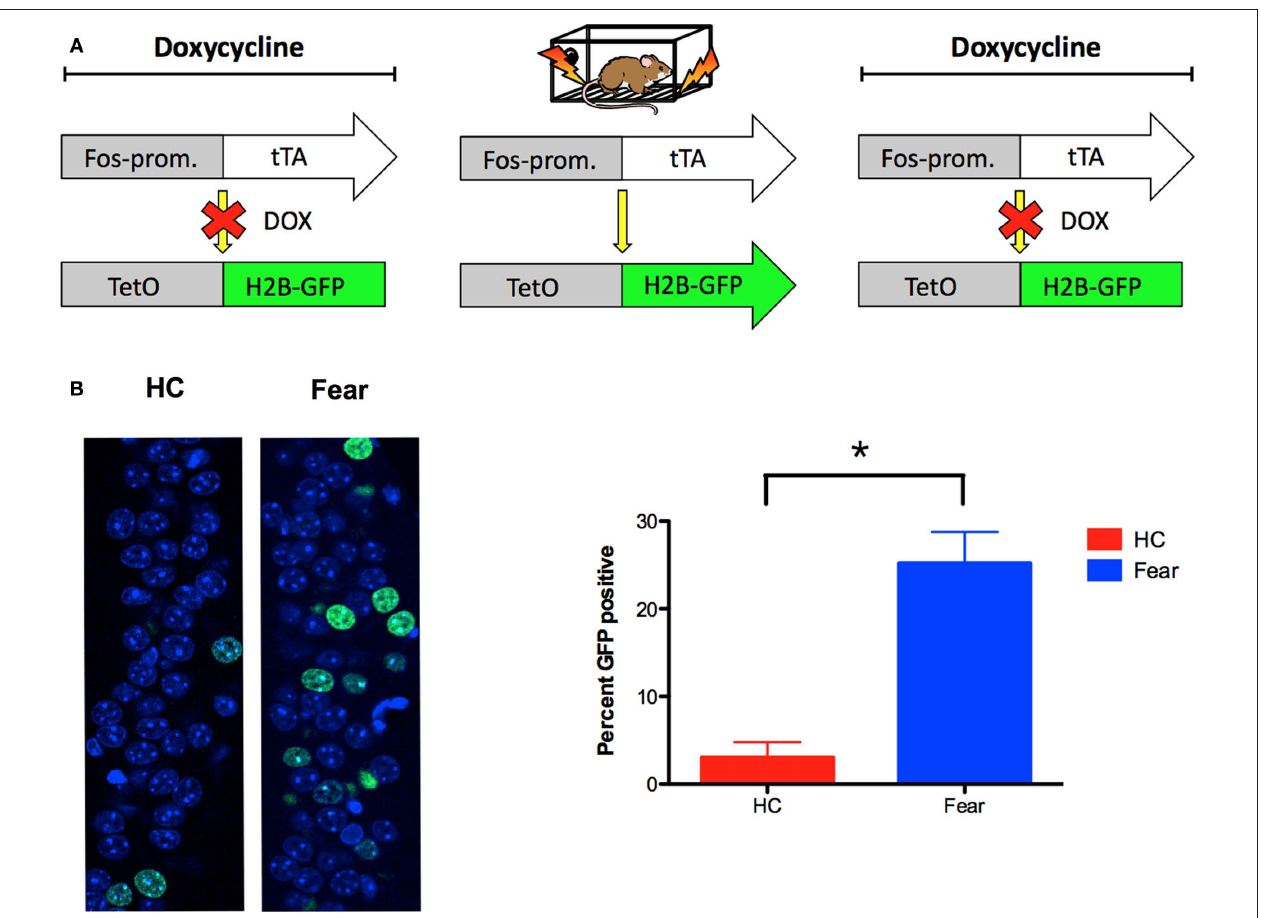
histone-GFP fusion protein, which is stable for several months after induction. (B) Fear-conditioned TetTag mice ( n = 5) demonstrated significantly more GFP expression in CA1 relative to off-DOX homecage controls ( n = 3). GFP expression was detected 5 days after training (green), and counterstained